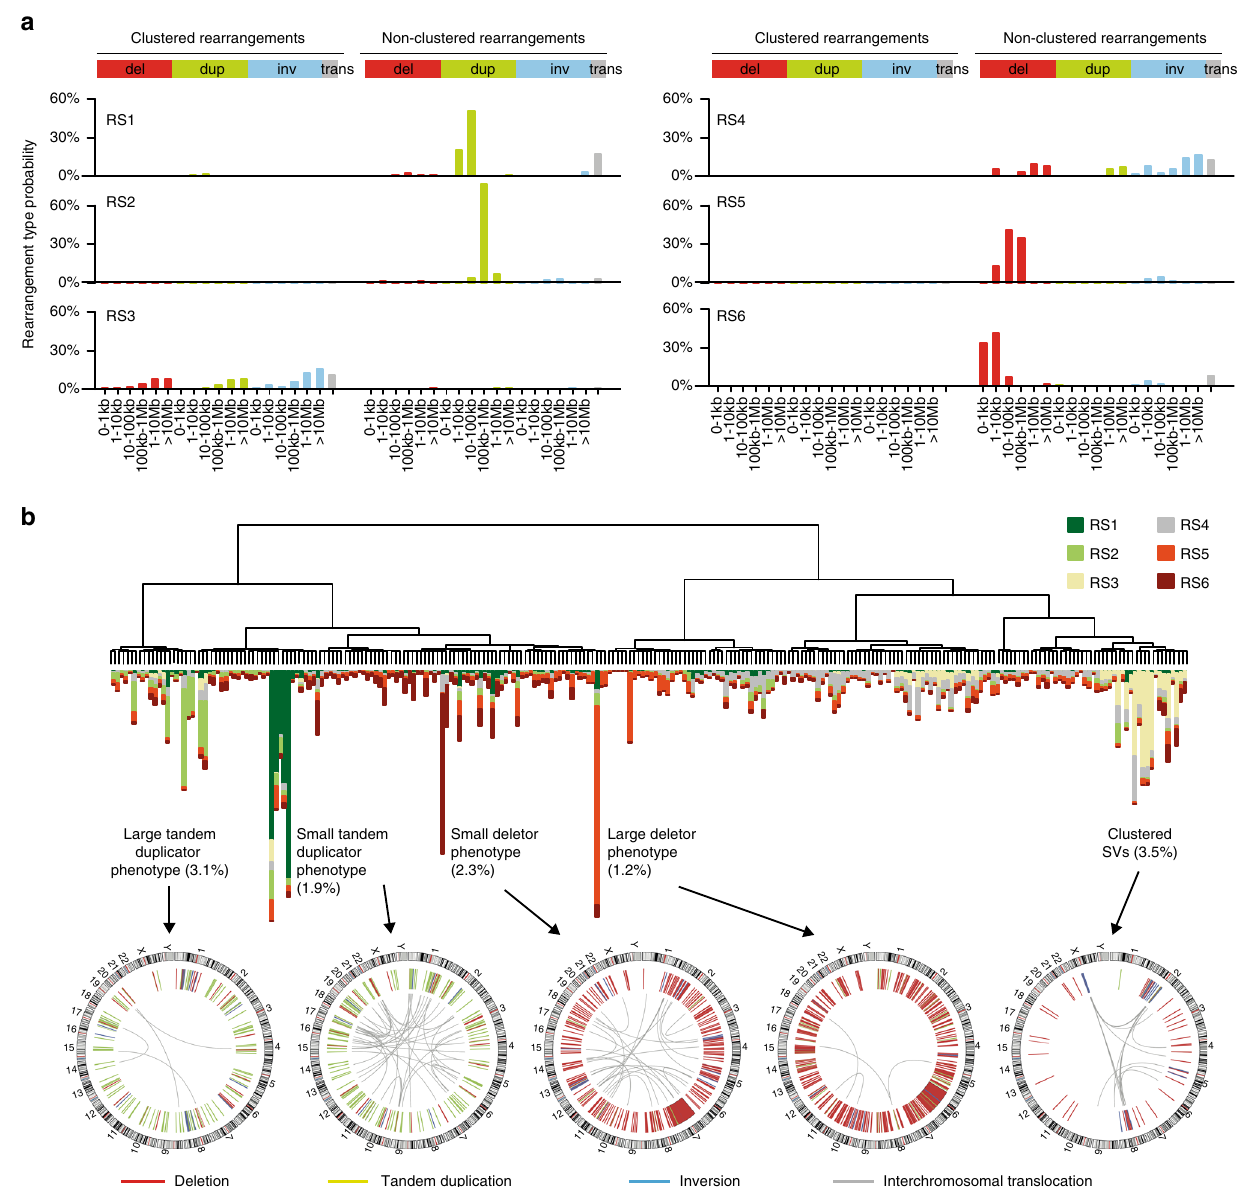
Fig. 3 Structural rearrangement signatures in liver cancer. a Six rearrangement signatures identi fi ed by non-negative matrix factorization. Structural rearrangements were classi fi ed in 38 categories considering their type (del: deletion, dup: tandem duplication, inv: inversion, trans: interchromosomal translocation) and size, and distinguishing clustered from non-clustered events. The probability of each rearrangement category in each signature is represented, with rearrangement types indicated above and rearrangement sizes below. b Unsupervised classi fi cation reveals HCC subgroups with similar rearrangement signatures. Particular phenotypes, de fi ned by the presence of ≥ 50 rearrangements attributed to a same signature, are indicated, with the percentage of tumors displaying the phenotype in parenthesis. Below, CIRCOS plots represent the structural rearrangement pro fi les of 5 tumors representative of particular structural rearrangement